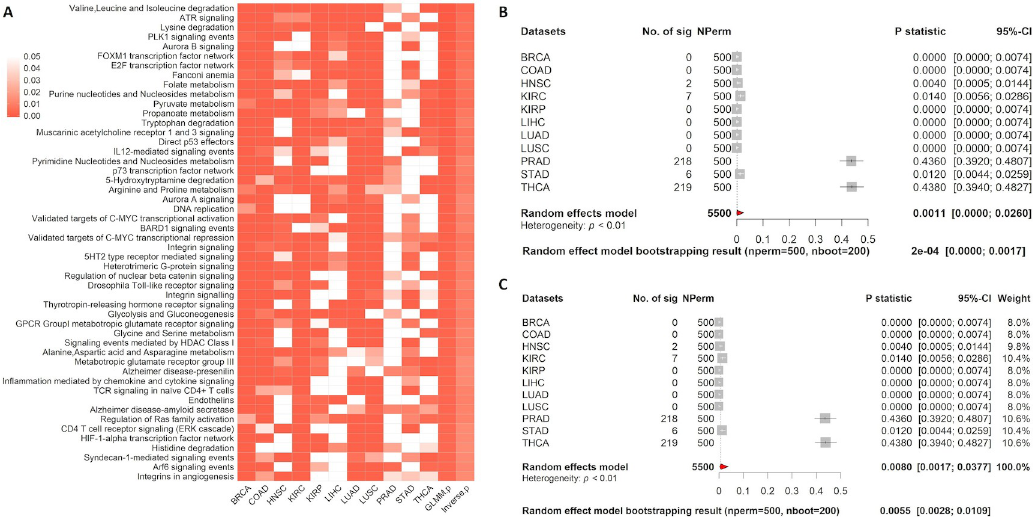
Fig 4. Pan-cancer MetaGSCA analysis in 11 cancer types, unpaired. A) The heatmap displays the top 50 pathways that MetaGSCA identified. The first 11 columns display the bootstrap p -statistic for each cancer type. Columns 12 and 13 are the meta- analysis p -statistic for the GLMM and the inverse variance method, respectively. B) Forest plot for meta-analysis results of the IL12 signaling mediated by STAT4 pathway with the GLMM option. C) Forest plot for meta-analysis results of the IL12 signaling mediated by STAT4 pathway based on the inverse variance method. In the forest plot, the dotted line denotes the meta p -statistic. Individual studies having stronger differential coexpression than the overall effect are left of the dotted